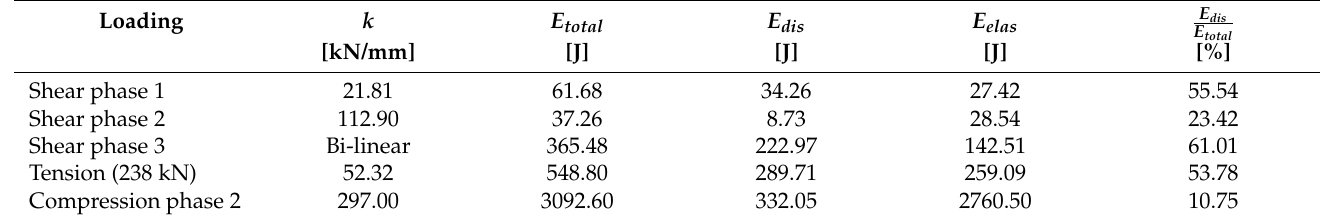
Table 4. Stiffness, energy values, and energy ratios obtained from